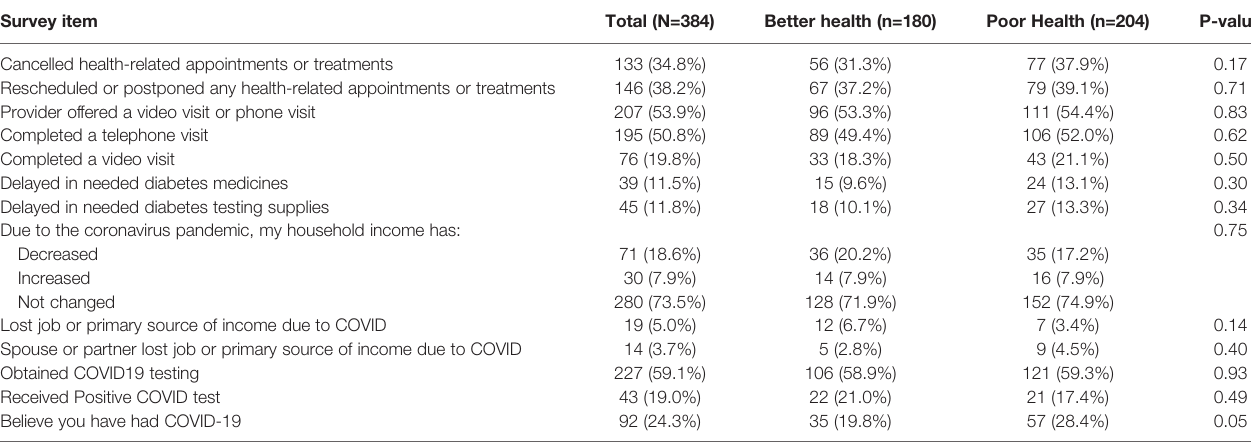
TABLE 4 | Responses to COVID speci fi c questions by self-reported health status among survey participants who participated during COVID (October 2020 to May 2021). Survey item